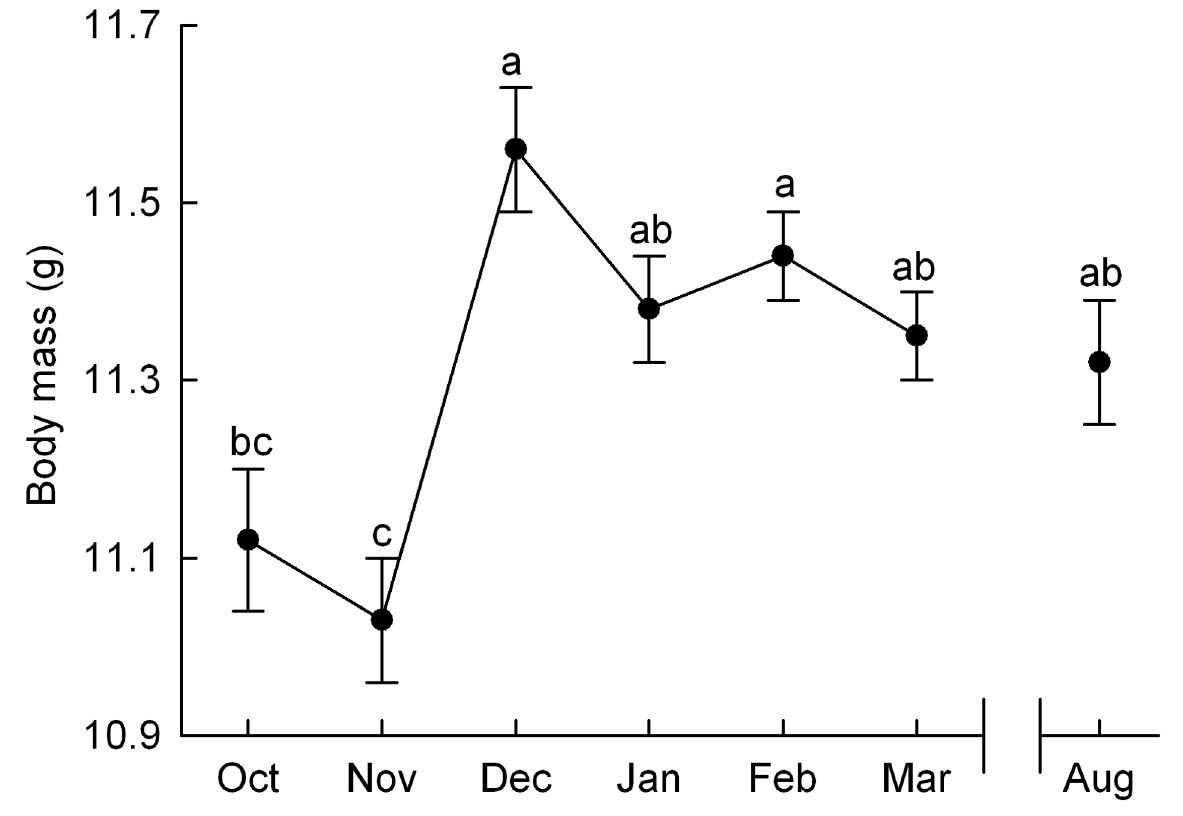
Figure 2. Intra-seasonal changes in body mass. Data are least square means of body mass controlling for year, month, time of capture, sex with bird ID as random parameter. Different letters represent significant difference between months. doi: